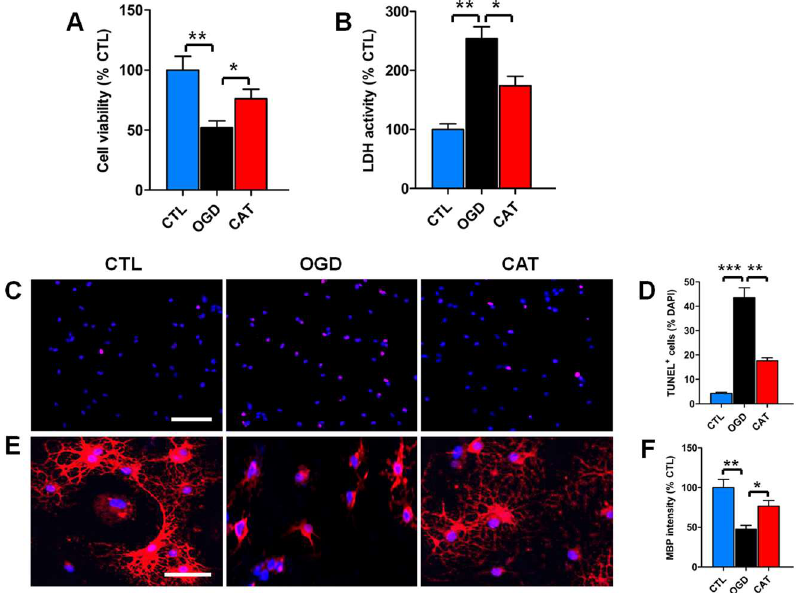
Figure 2. Effects of catalpol on PreOL survival and maturation under oxygen-glucose deprivation (OGD). ( A ) Quantification of cell viability as measured by the 3-(4,5-dimethylthiazol-2-yl)-2,5-diphenyltetrazolium bromide (MTT) assay in the control (CTL), OGD-treated (OGD), and catalpol-treated (CAT) groups. ( B ) Quantification of lactate dehydrogenase (LDH) activity in the CTL, OGD, and CAT groups. ( C ) Representative terminal deoxynucleotidyl transferase-mediated dUTP-biotin nick end labeling assay (TUNEL) staining (red) in the CTL, OGD, and CAT groups. Cell nuclei were counterstained with 4’,6’-diamidino-2-phenylindole (DAPI) (blue). Bar = 50 μm. ( D ) Quantification of TUNEL-positive cells in the CTL, OGD, and CAT groups. ( E ) Representative MBP staining (red) in the CTL, OGD, and CAT groups. Cell nuclei were counterstained with DAPI (blue). Bar = 25 μm. ( F ) Quantification of the optical density of MBP staining in the CTL, OGD, and CAT groups. Data are shown as means ± SEM ( n = 6 in each group). * p < 0.05; ** p < 0.01; *** p < 0.001.